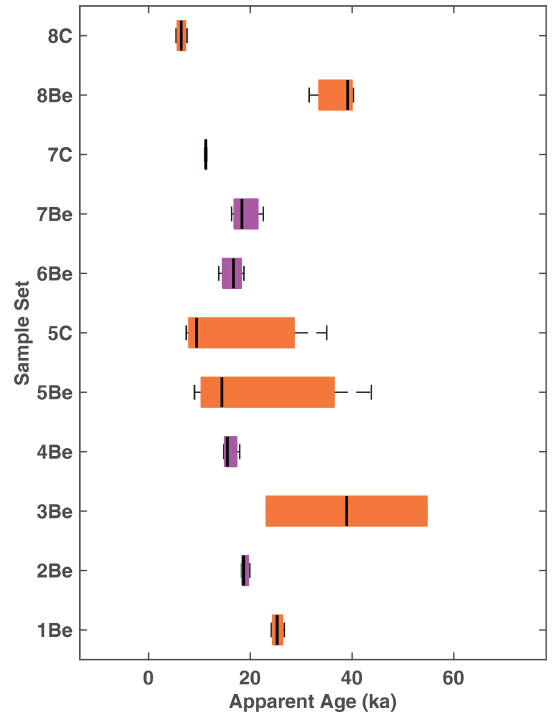
Figure 4. Box-and-whisker plot of moraine ages for the inner moraines (purple) and the outer moraines (orange) as identified by their site number and nuclide. Median ages are indicated by black lines. Note the larger magnitude of scatter and outlier spread for the outer moraines relative to the inner moraines. The larger spread for the carbon measurements from set 5 results from the measurement of one saturated age.